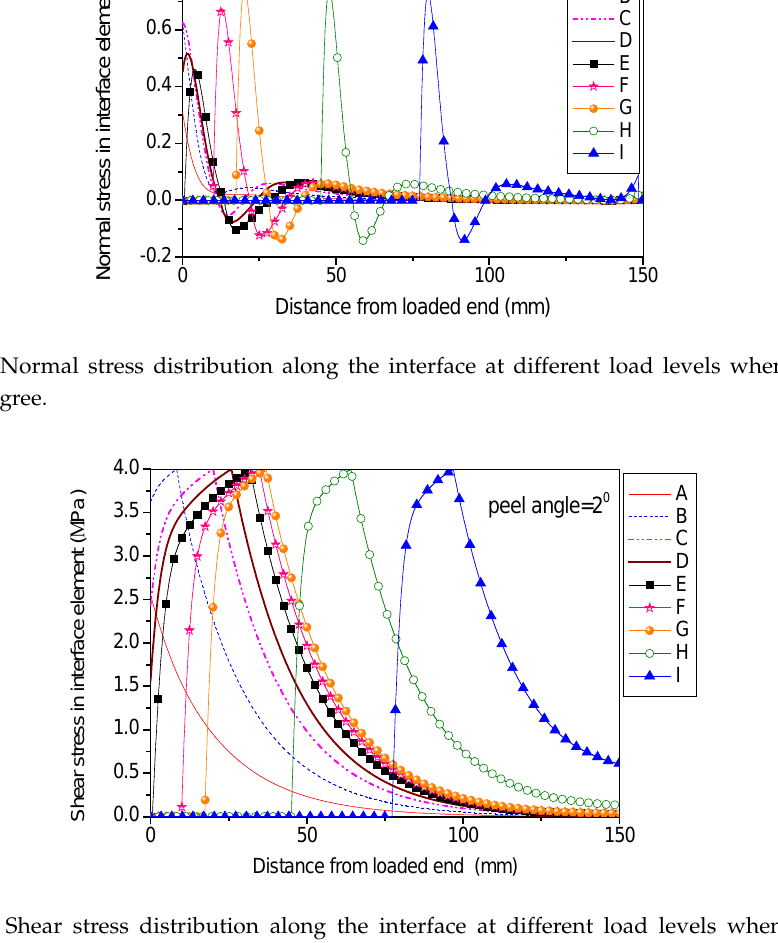
Figure 20. Shear stress distribution along the interface at different load levels when the peel angle = 2 degree.